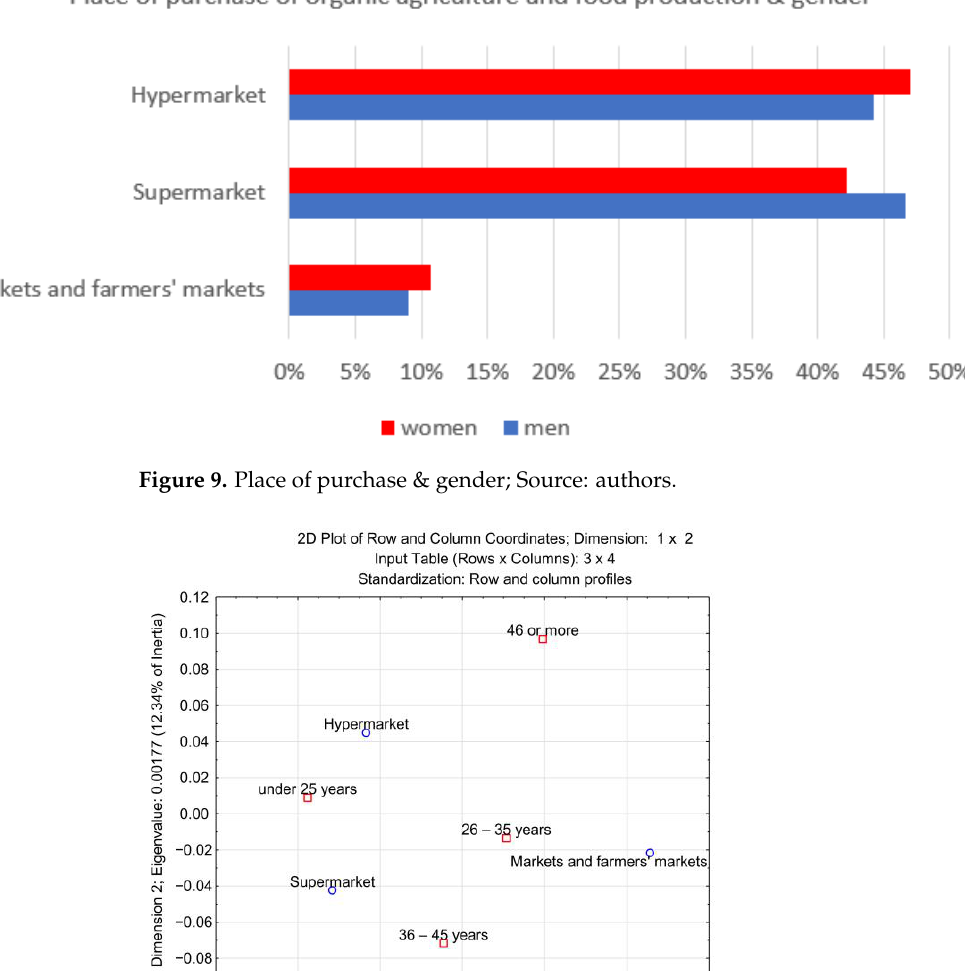
10 of 15 Figure 8. Correspondence maps, Markets and farmers’ markets & Respondent’s education. Source: